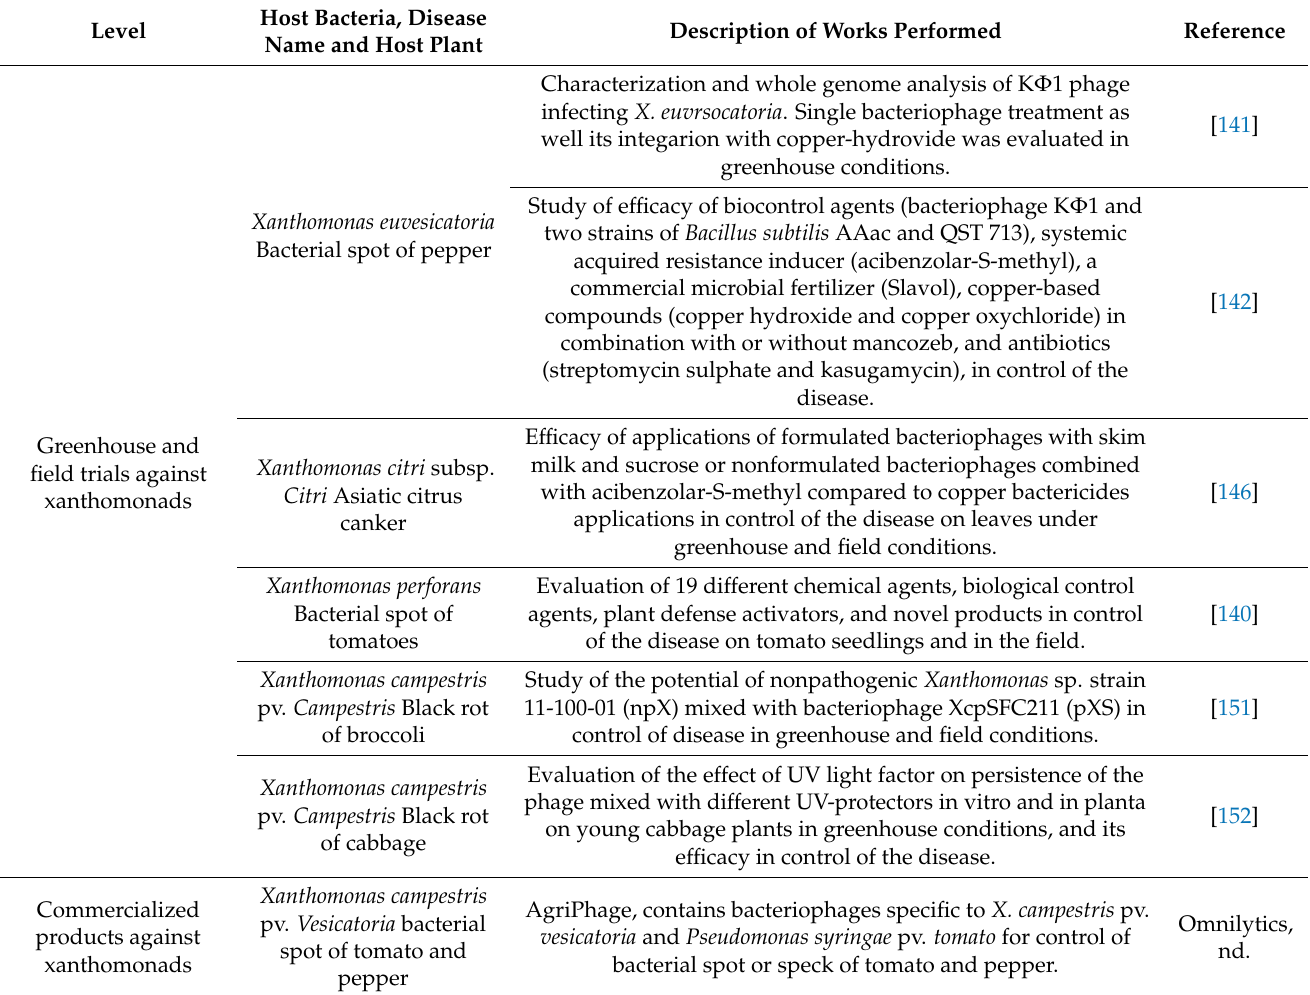
Table 2. List of recent studies of bacteriophage-based biocontrol for diseases caused by Xanthomonas spp.